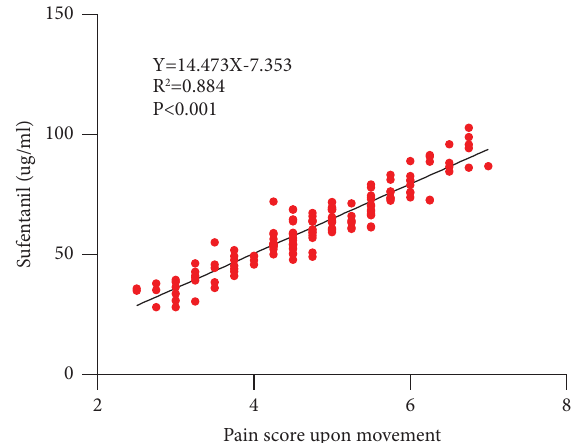
Figure 3: Linear regression analysis. Te mean pain score upon movement within 48 hours after surgery was the independent variable ( X ). Te cumulative dose of sufentanil within 48hours after surgery was the dependent variable ( Y ). Te diference was signifcant at the P < 0 . 05